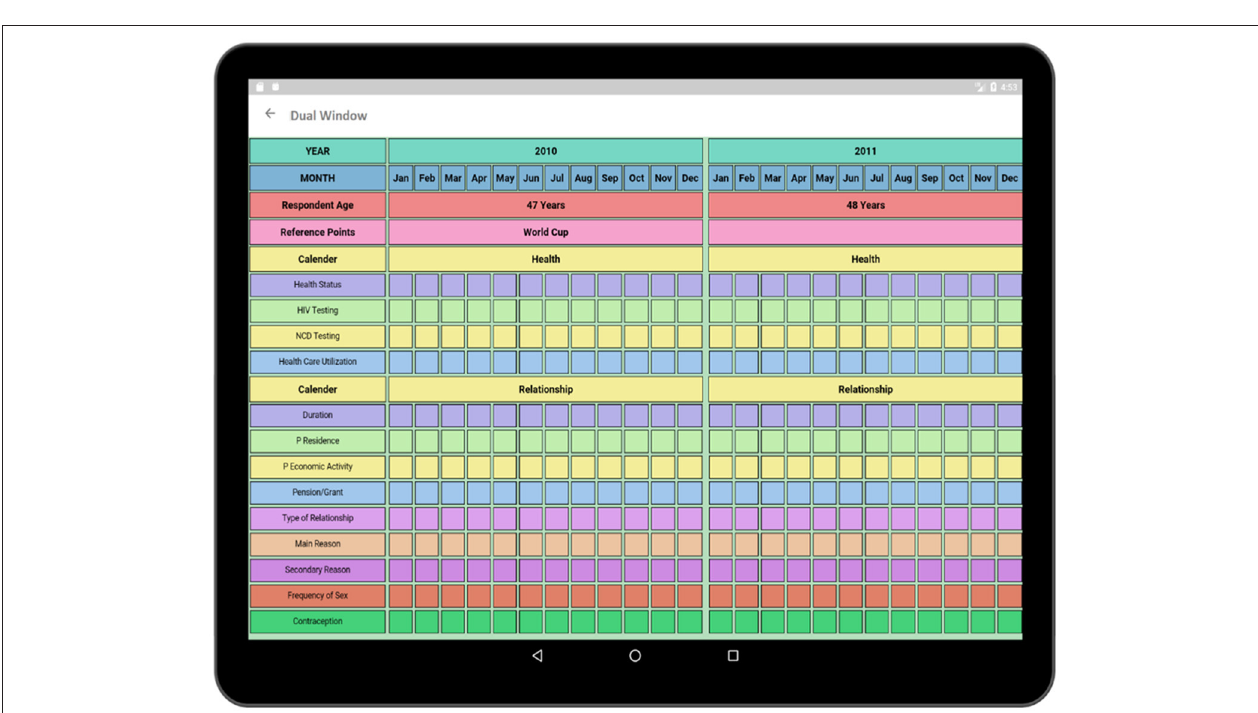
FIGURE 14 | Dual window (compares two surveys to find out the internal relationship between two sectors).